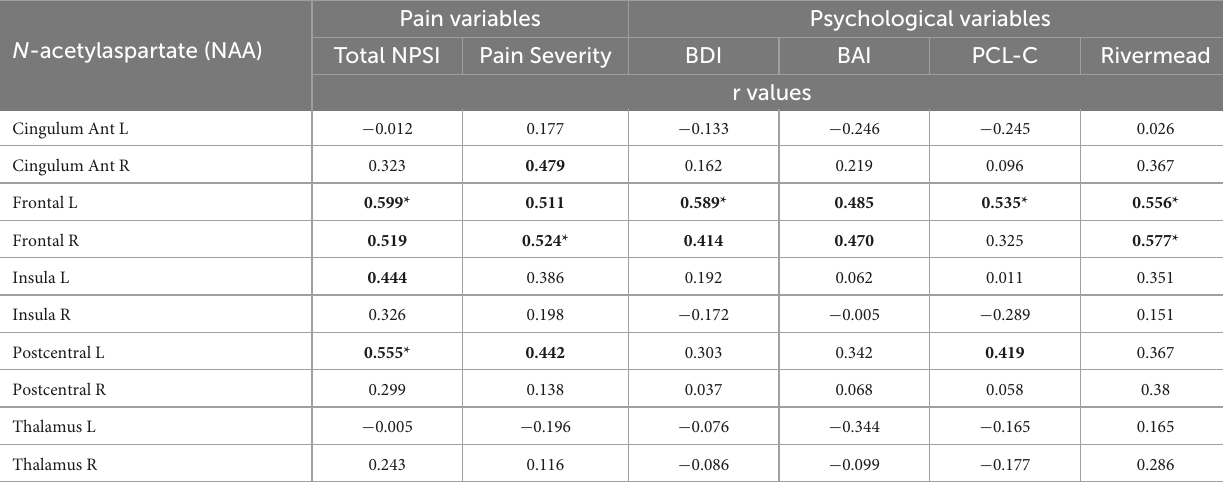
TABLE 8 Pearson correlation coefficients (r) of partial correlations between N -acetylaspartate (NAA) levels of the TBI pain group (TBI-P, N = 16) and pain and psychological variables, controlling for